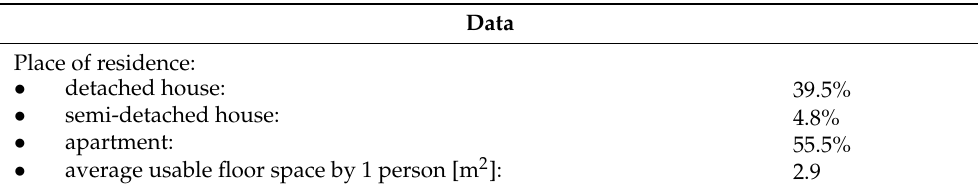
Table 10. Profile of the proximate space of a Polish senior. Source: own elaboration on the basis of [90–101].